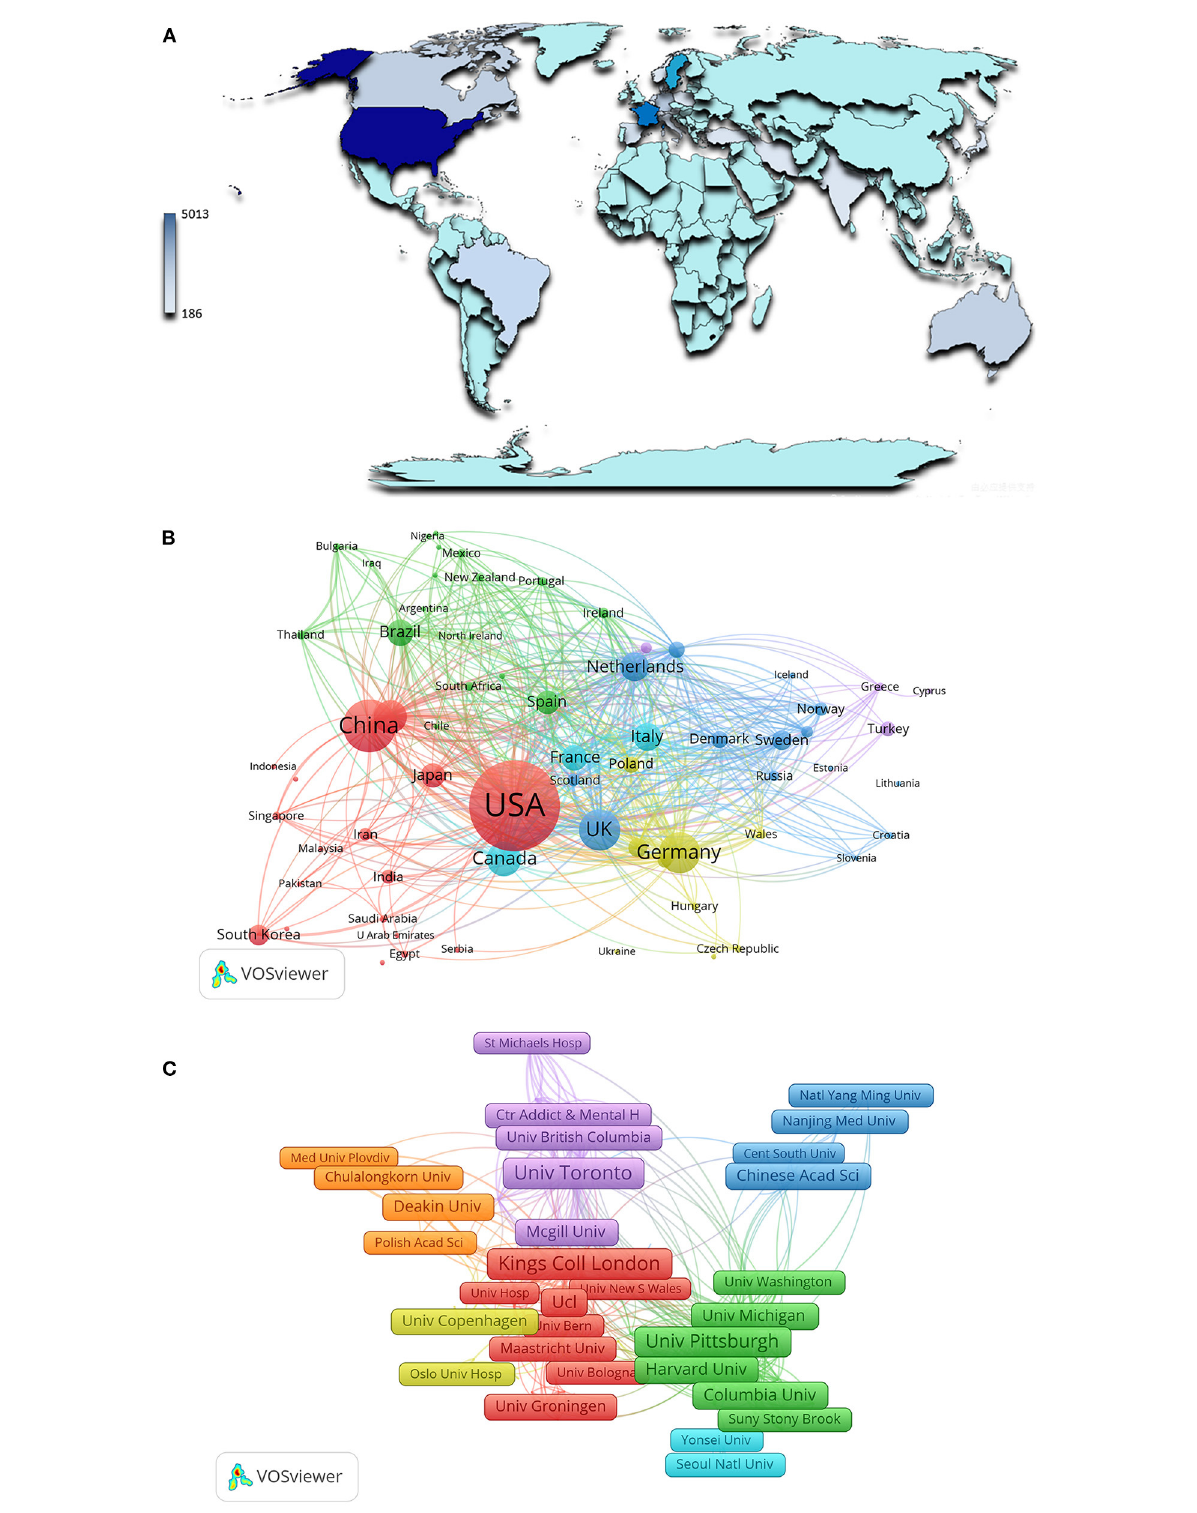
FIGURE2 Main countries/regions and institutions of depression biomarker research and their interrelationships. (A) Countries/Regions distribution of depression biomarker research results; (B) A visualization network of collaboration between countries/regions in depression biomarker research; (C) A visualization network of collaboration among institutions in depression biomarker research. The nodes in the map denote elements such as a country or institute, and link lines between nodes denote collaborative relationships. The larger the circle/frame, the more articles are published. The wider the line, the stronger the